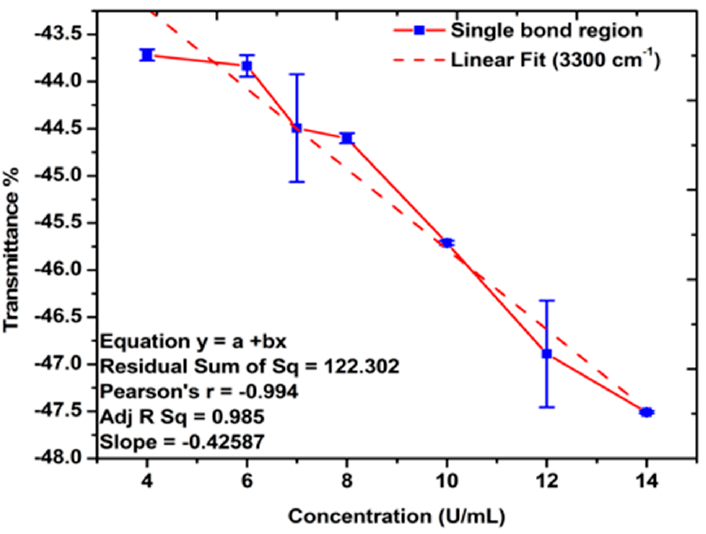
Figure 5. Linear relations between the transmittance % and concentration of antigen CA72-4. Quantitative analysis for the single-bond (C-H, C-N, N-H stretching, amide, proteins v (N-H), and C-H bending) region.